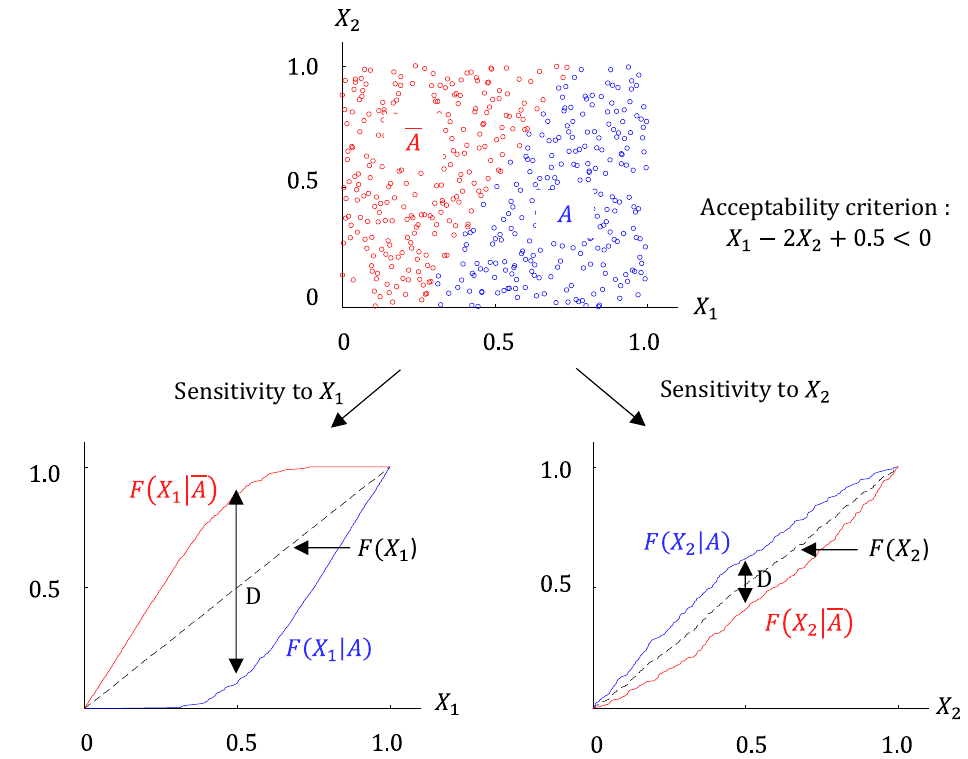
Figure 5. A simple example of Monte Carlo filtering and the resulting conditional distributions. The large distance between F ( X 1 | A ) and 𝐹(cid:3435)𝑋 (cid:2869) (cid:3627)𝐴(cid:3439) indicate a high sensitivity to 𝑋 (cid:2869) , especially around X 1 = 0.5 .